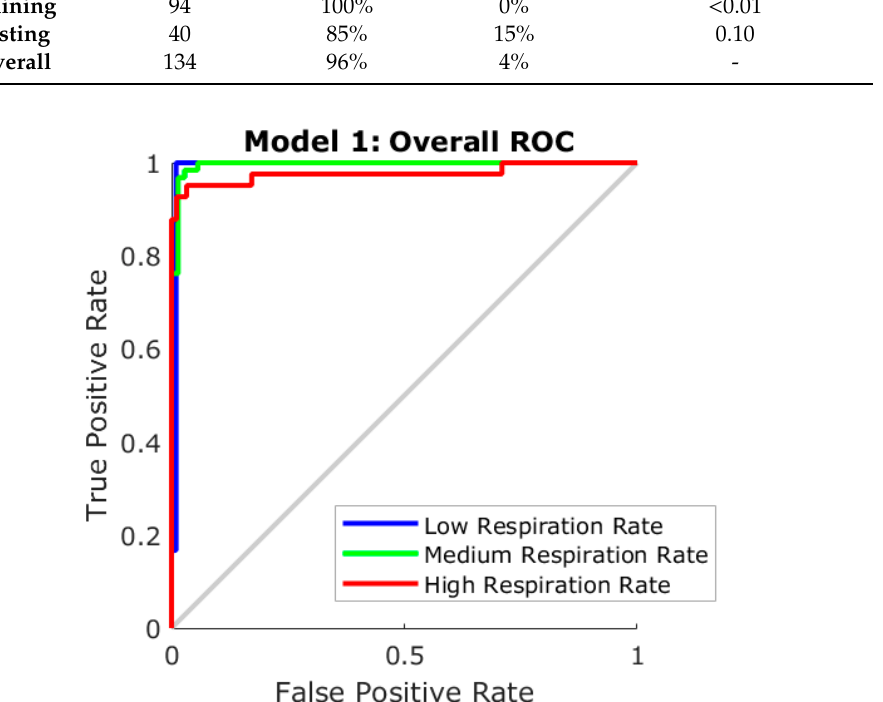
Figure 5. Receiver operating characteristics (ROC) curve of the pattern recognition (Model 1) depicting the true-positive and false-positive rates.